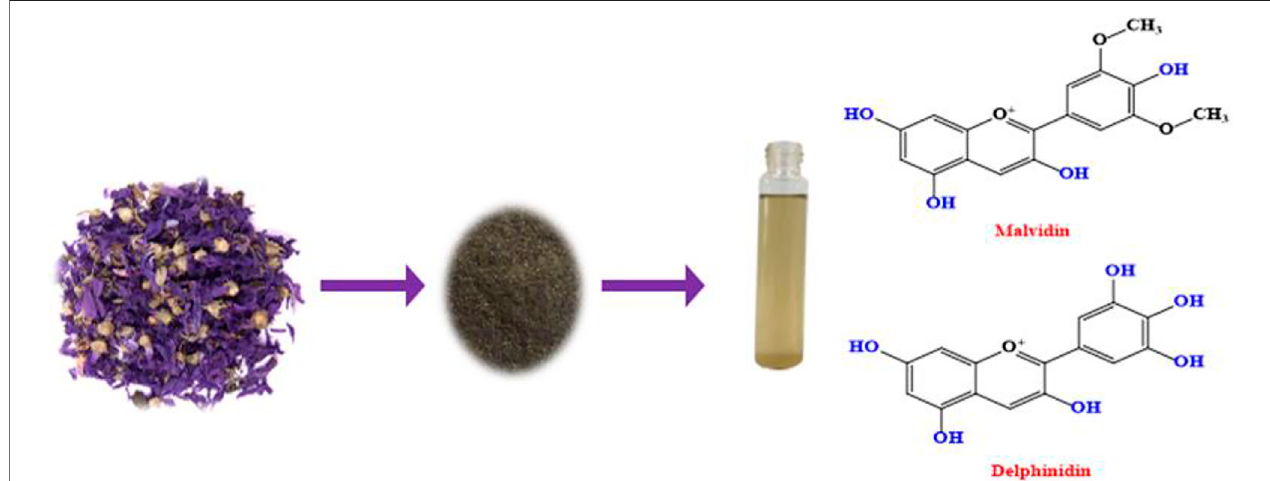
FIGURE 1 | The preparation of MS extract.